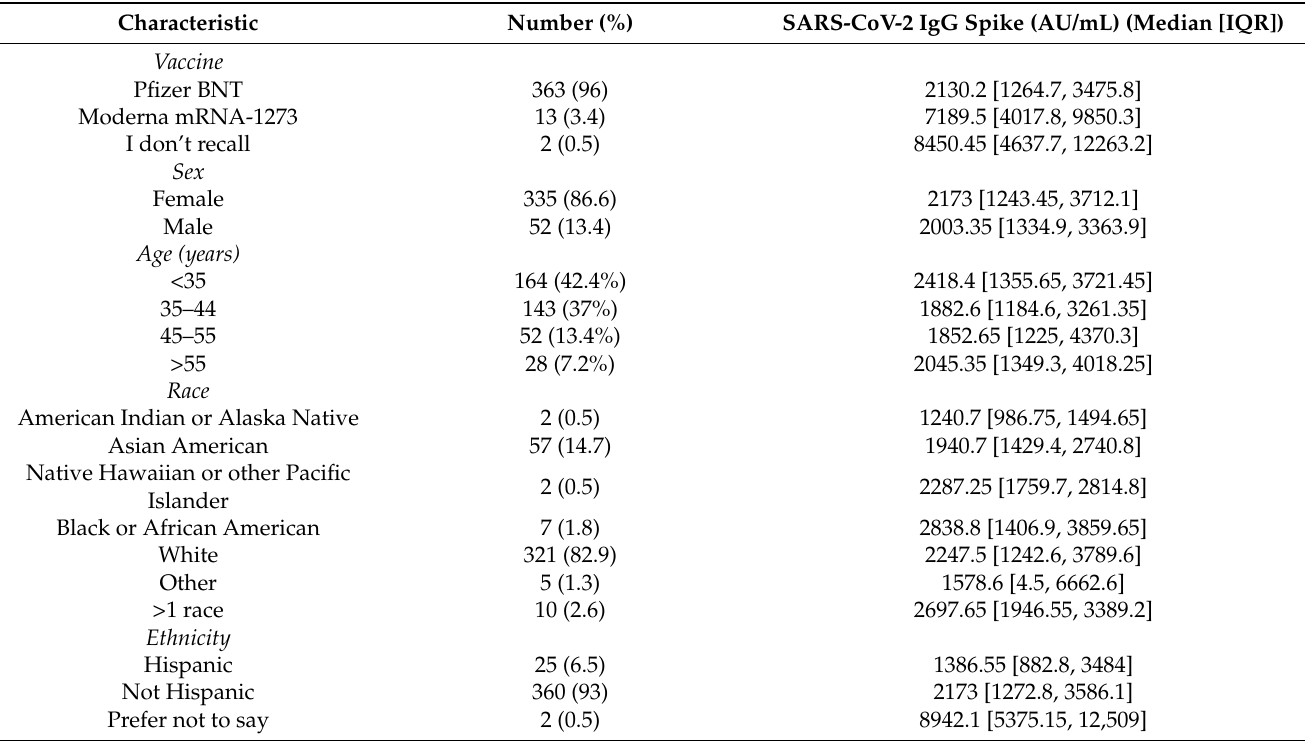
Table 1. Population Demographics.